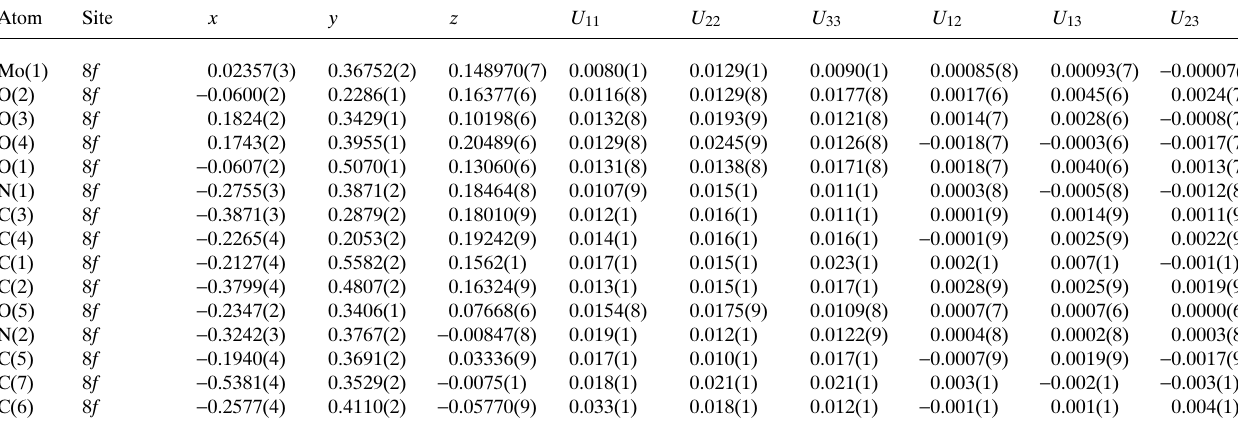
Table 3. Atomic coordinates and displacement parameters (in Å 2 ) .